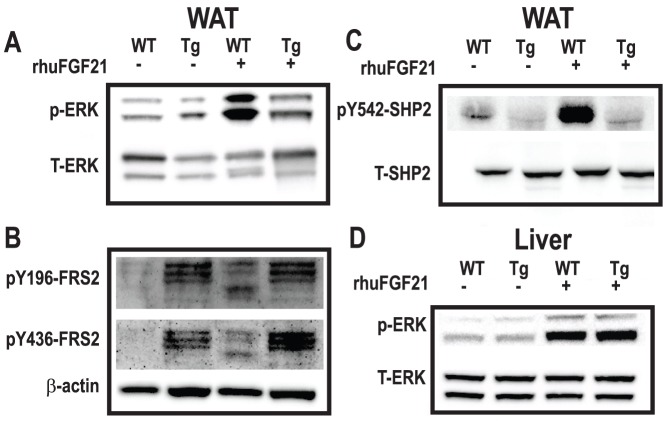
Impaired FGF21 signaling in adipose tissue from lipodystrophy mice.Wildtype (WT) and aP2-nSrebp1c lipodystrophy (Tg) male mice were treated with vehicle (−) or a single rhuFGF21 (+) injection at 1 mg/kg (Animal Study Design II – Methodology). White adipose tissue (WAT) samples were subjected to immunoblot analysis with antibodies directed against (A) ERK (extracellular signal-regulated kinase), (B) FRS2 (Fibroblast growth factor receptor substrate (C) SHP2 (Src homology domain 2 containing protein tyrosine phosphatase), 2), (D) ERK signaling was analyzed in liver samples. Antibodies directed against phosphorylated (p-) or total (T-) proteins of specific resides are noted alongside each panel.